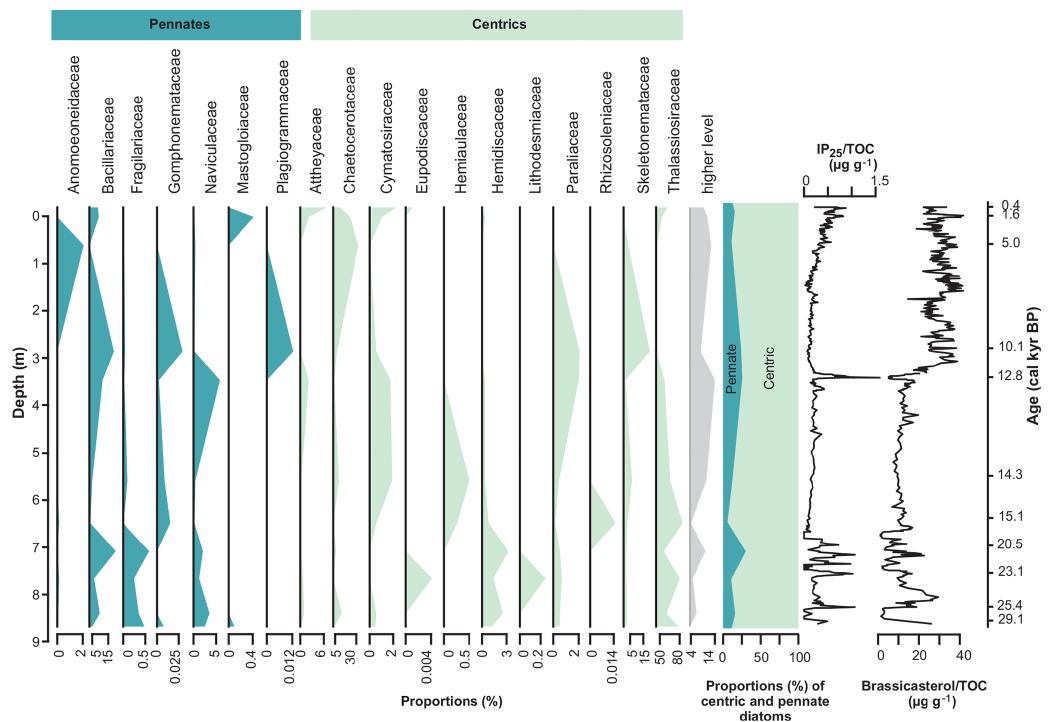
Figure 6. Proportions of sequences assigned to diatoms grouped on family level and down-core proportions of centric (blue) and pennate diatoms (green) as well as concentrations of the sea-ice biomarker IP 25 (Müller et al., 2012; Müller and Stein, 2014) and the phytoplankton biomarker brassicasterol (Müller et al., 2012; Müller and Stein, 2014). Higher level (grey) contains sequences assigned between family and phylum level. TOC: total organic